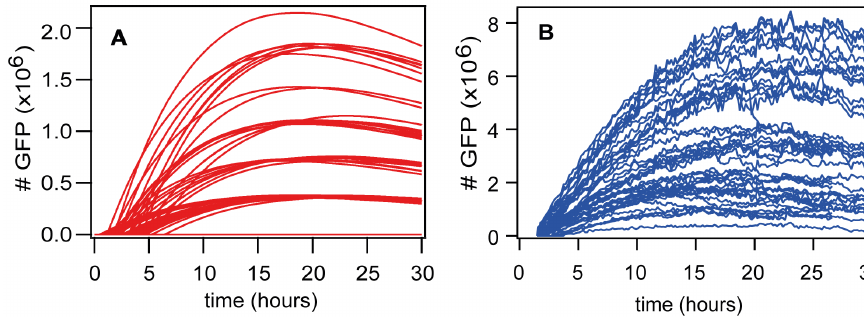
Figure 4. GFP expression: simulation vs. experiment. A) Computer simulation. B) Experimental time courses.